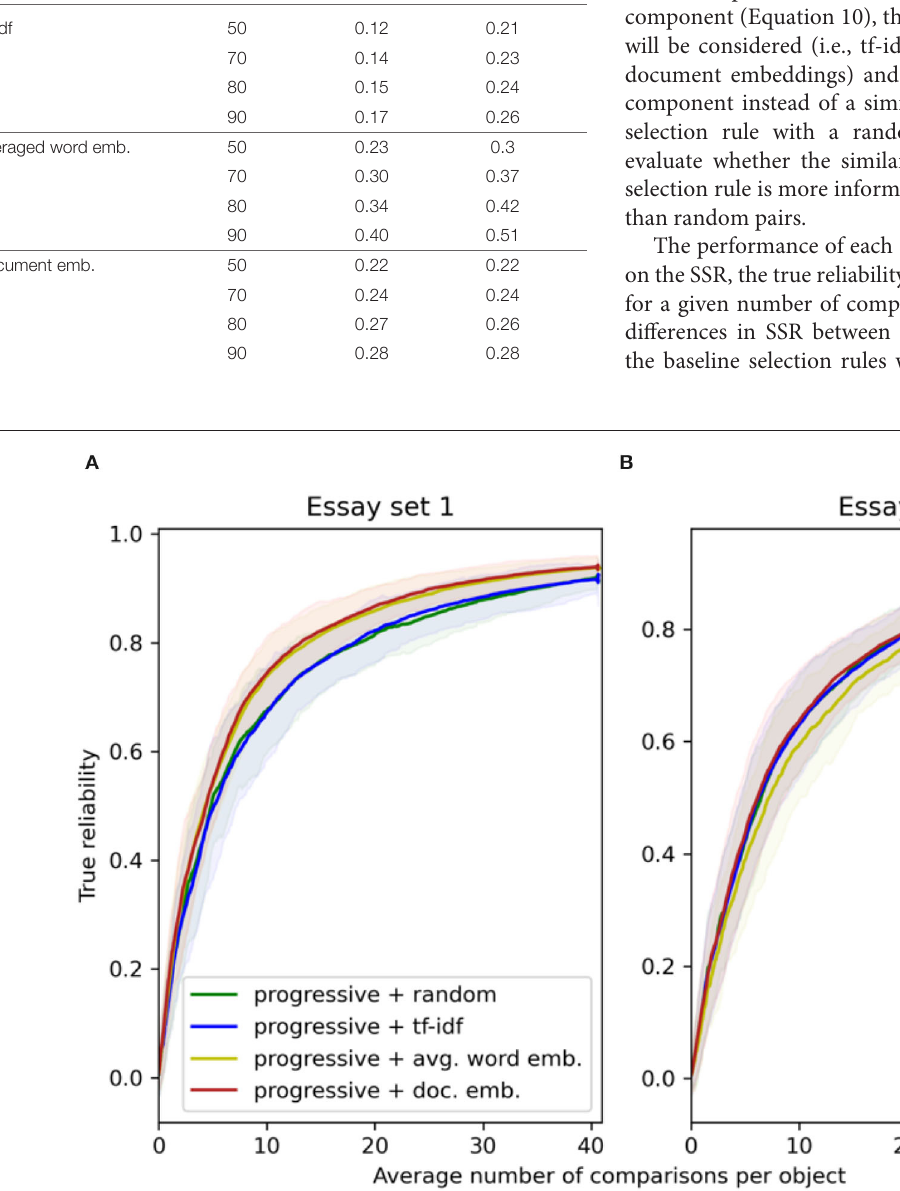
TABLE 2 | Quantiles of the cosine similarities between essays using different essay representation techniques for two essay sets. Essay representation